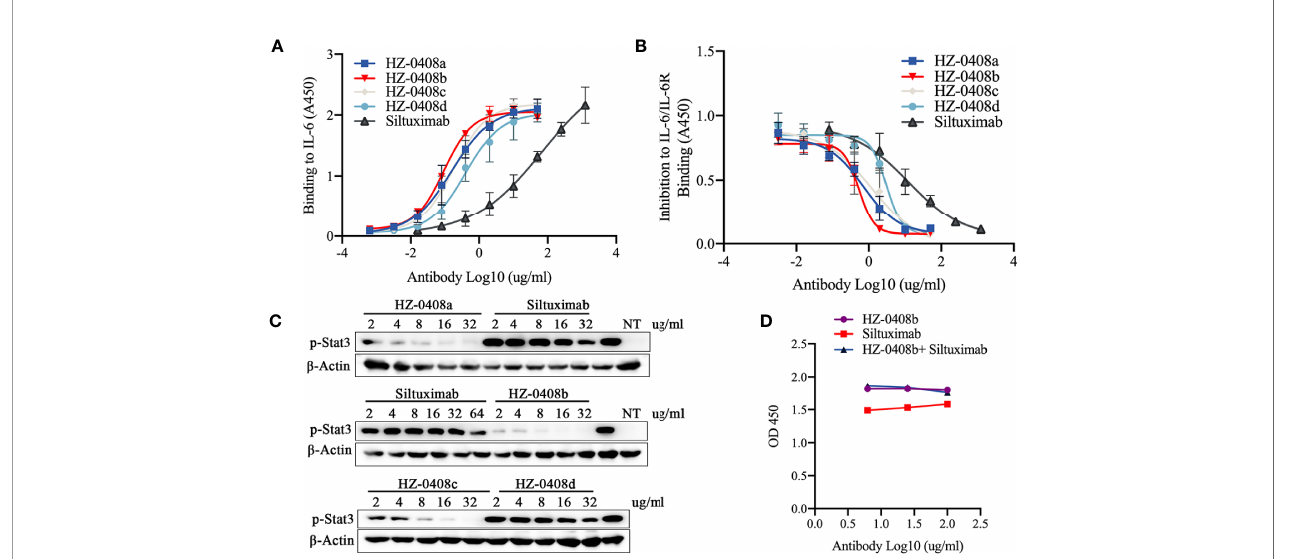
FIGURE 1 | Generation, humanization, and characterization of anti-human IL-6 monoclonal antibody HZ-0408b. (A) The binding activity of the humanized anti-IL-6 mAbs and Siltuximab to IL-6 was measured by ELISA using an HRP-conjugated anti-human IgG secondary antibody. Each sample was assayed in triplicates. Mean absorbance at 450nm and SD values are presented. (B) The inhibitory effect of humanized anti-IL-6 mAbs and Siltuximab on IL-6 and IL-6R binding was measured by ELISA. Each sample was performed in triplicates. Mean absorbance at 450nm and SD values are presented. (C) The humanized anti-IL-6 mAbs and Siltuximab inhibited STAT3 signaling activity. DLD-1 cells were cultured in the presence of 10ng/ml IL-6 and indicated concentrations of humanized anti-IL-6 mAbs and Siltuximab were added for 2 hr. STAT3 phosphorylation at T705 was measured by western blot. NT, nontreated with IL-6. (D) HZ-0408b and Siltuximab binding to rhIL-6-His were analyzed by competitions with equal amount of limiting diluted HZ-0408b and Siltuximab at 100ug/ml, 25ug/ml, and 6.26ug/ml, respectively as described in